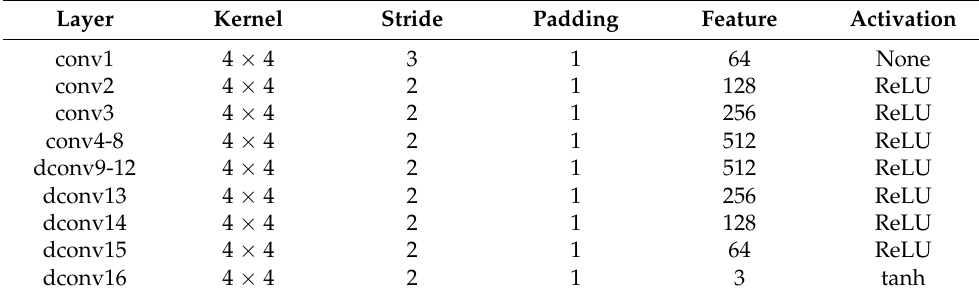
Table 1. Detailed configuration of the used